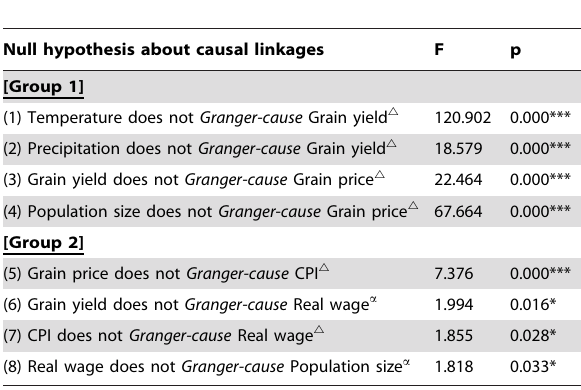
Table 3. GCA Results for Each of the Causal Linkages by Low-Pass Filtered Data.